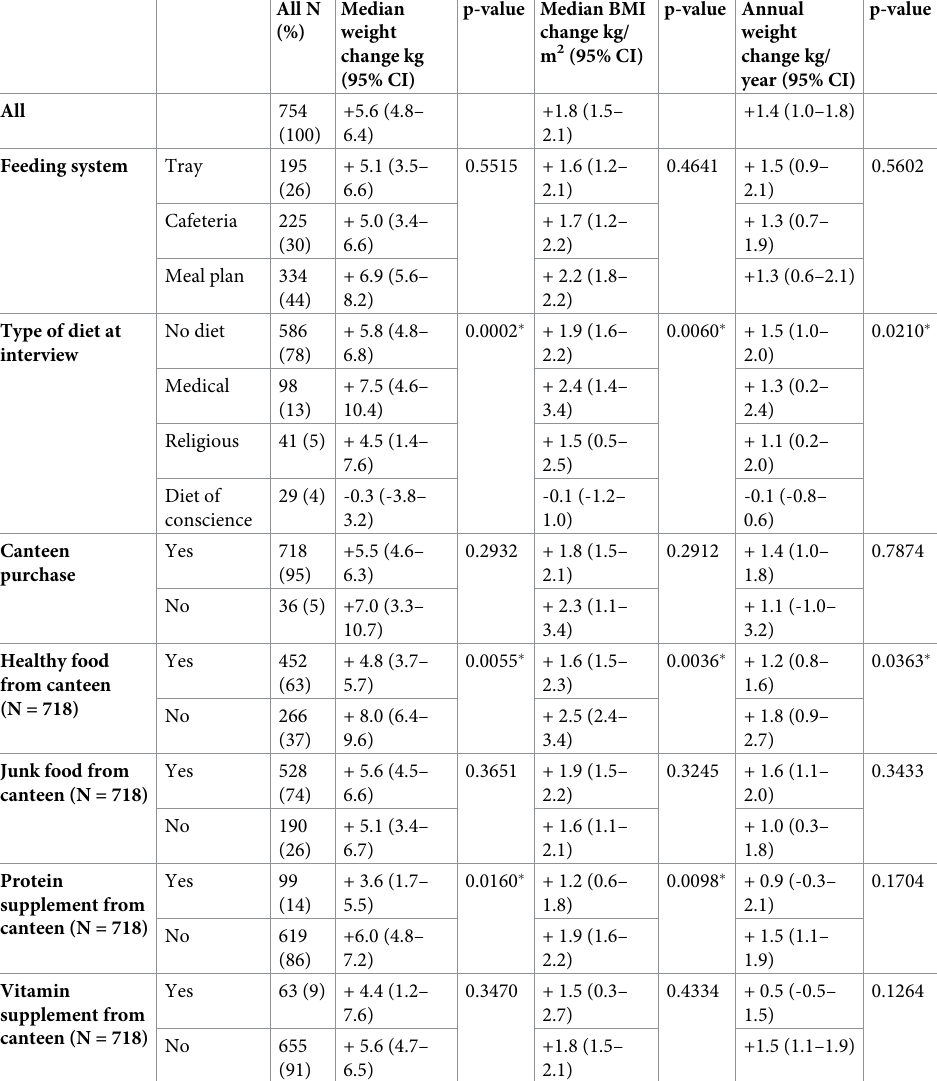
Table 3. Change in median weight, body mass index (BMI) and annual weight between admission and study fol- low-up in relation to feeding systems, type of diet, quality of food and intake